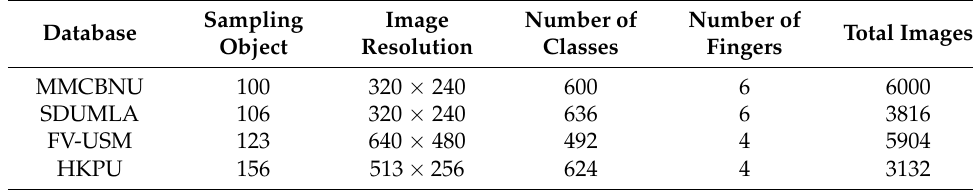
Table 1. Details of public finger vein